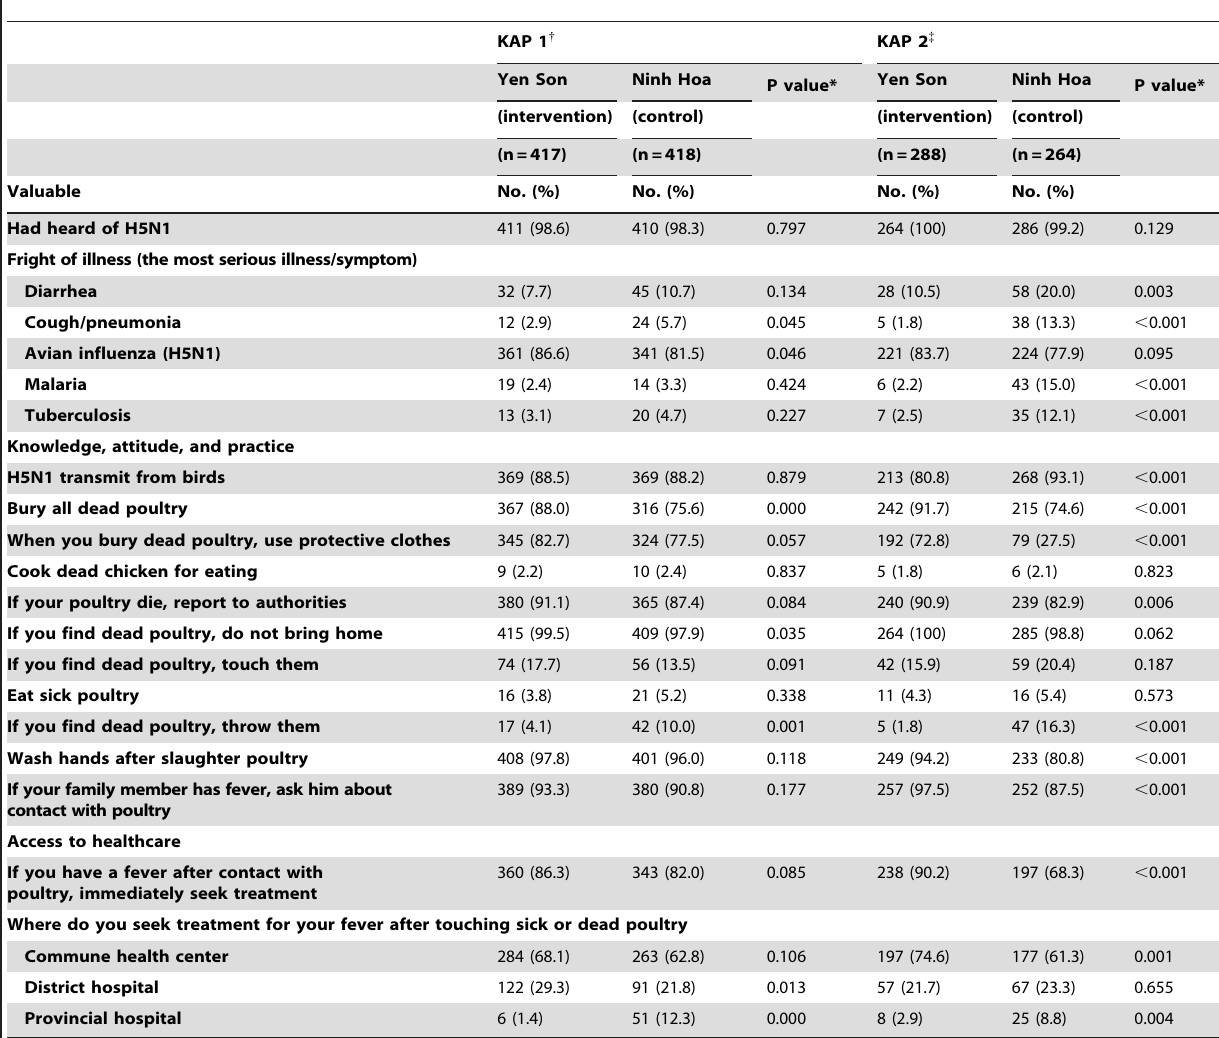
Table 3. Knowledge, attitude, and practice relating to avian influenza among study